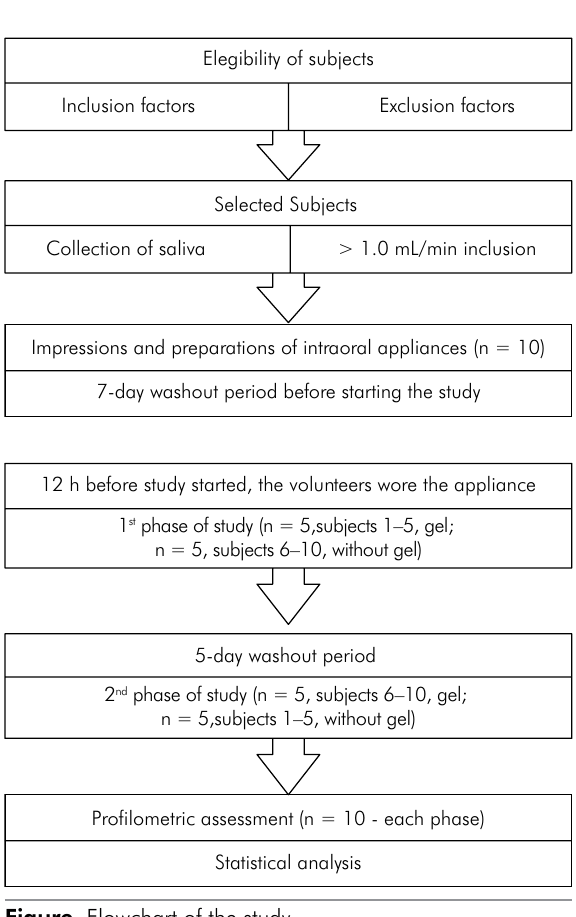
Figure. Flowchart of the